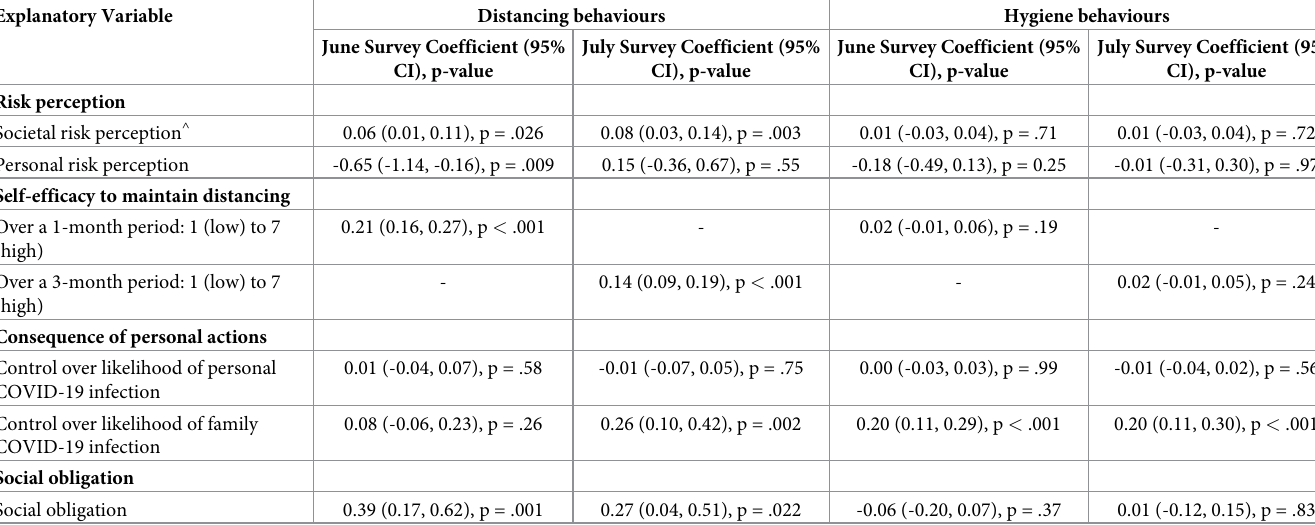
Table 6. Multivariable regression modelling of distancing and hygiene behaviours during the June and July Surveys, with baseline responses included as explanatory variables �